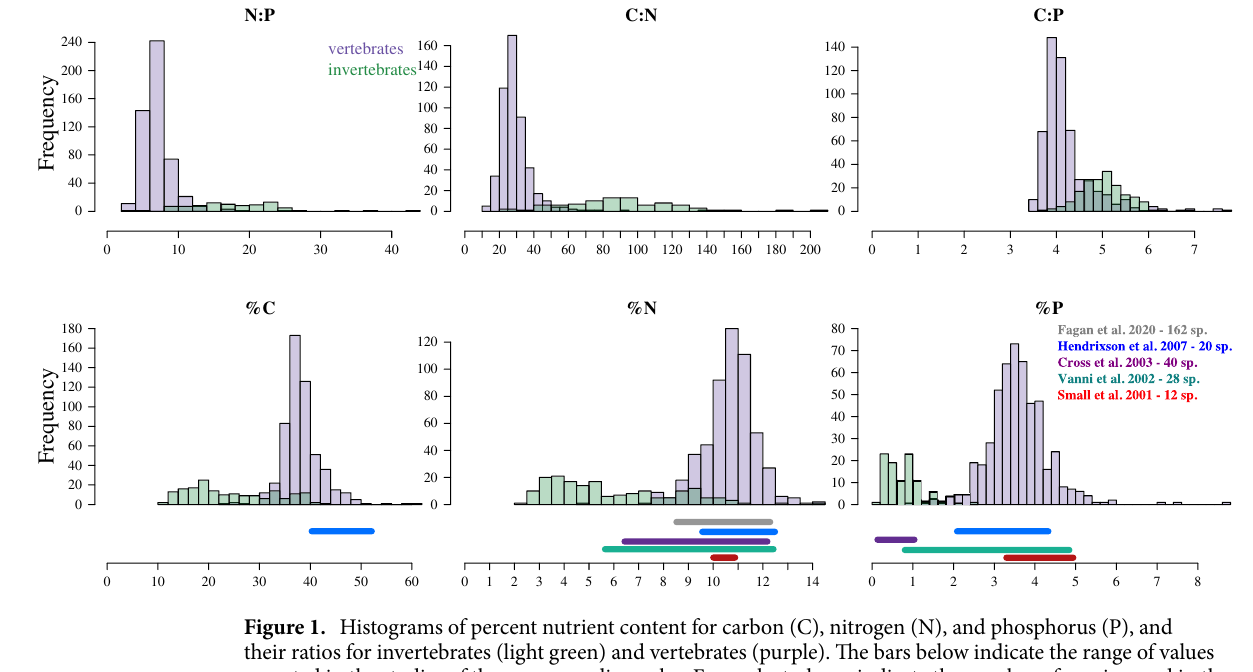
Figure 1. Histograms of percent nutrient content for carbon (C), nitrogen (N), and phosphorus (P), and their ratios for invertebrates (light green) and vertebrates (purple). The bars below indicate the range of values reported in the studies of the corresponding color. For each study we indicate the number of species used in the analysis. The current study analyzed 105